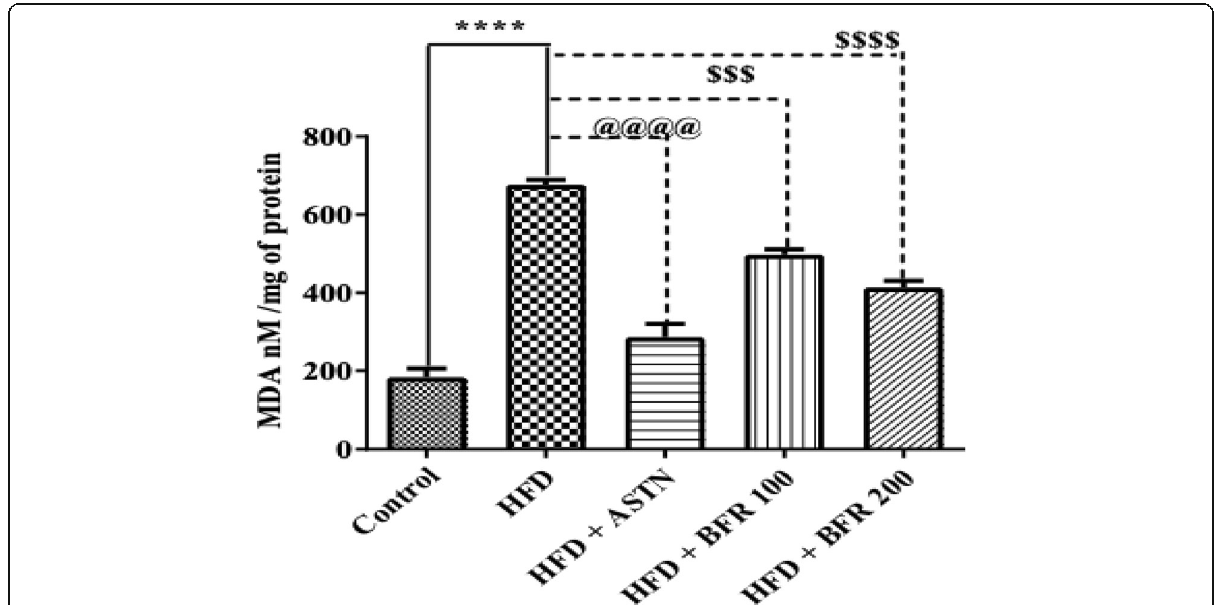
Fig. 4 Effect of BFR and ATSN in rat heart MDA level of high-fat diet-fed rats. Data were expressed as mean ± SD. Comparison made between HFD vs control and HFD + ATSN vs HFD group, HFD + BFR vs HFD. Statistical significance at **** ,@@@@ p < 0.0001 and $$$ p <